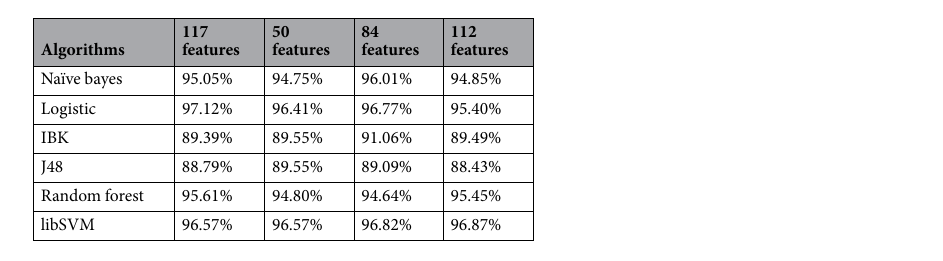
Table 1. The predictive results of different input parameters. (In this table, the 50 features were selected by the mRMR, the 84 features with the P-values less than 0.001 were selected by ANOVA and the 112 features were selected by